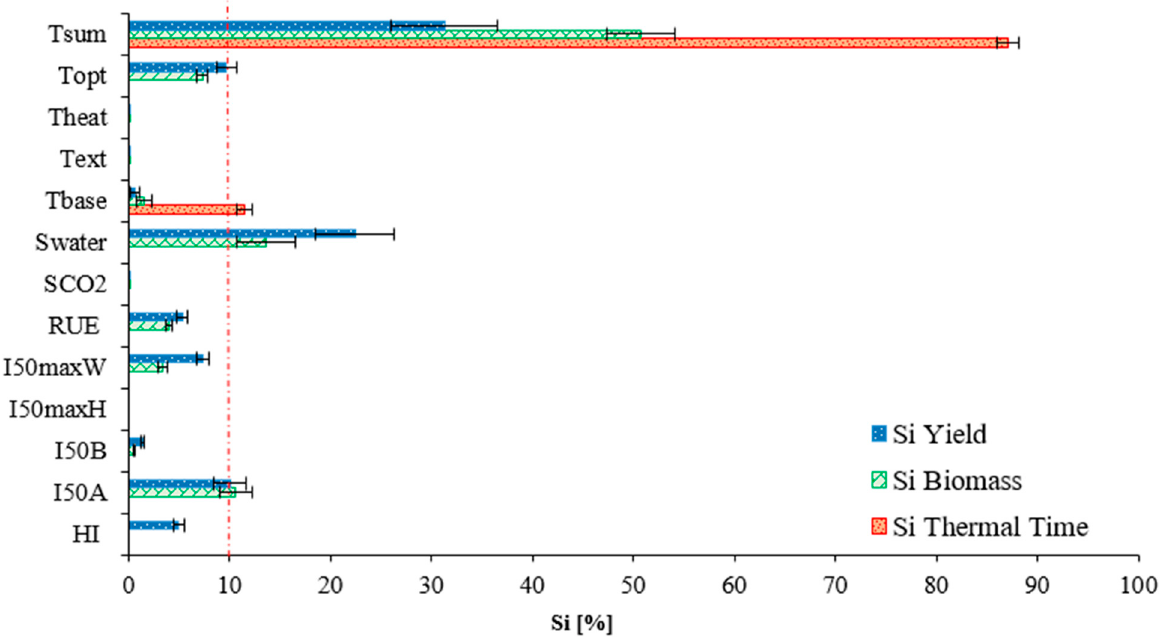
Figure 4. First order sensitivity indices (±standard deviation) with Sobol’s method for the irrigated bean crop for the variables predicted by the SIMPLE model; dashed line denotes a 10% threshold.